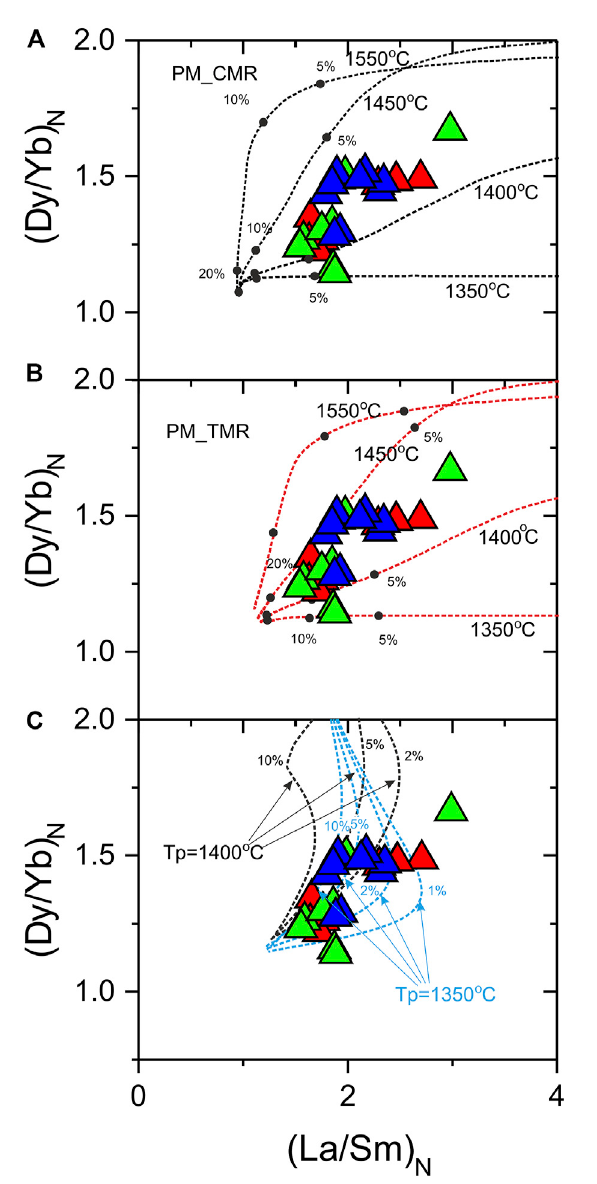
FIGURE 10 (La/Sm) N versus (Dy/Yb) N of the Ghatagaon, Keonjhar and Pipilia dyke swarms. (A) Forward models produced by melting primitive mantle in a columnar melting regime (PM_CMR) (McDonough and Sun, 1995)at mantle potential temperature from 1350 ° C to 1550 ° C. (B) Forward melting models produced by melting primitive mantle in a triangular melting regime (PM_CMR) (McDonough and Sun, 1995) at the same mantle potential temperatures in (A) . Black circles in the melting trajectories represent the degree of melting. (C) Forward model melts produced by melting hybrid lithologies of peridotite and pyroxenite (McDonough and Sun, 1995; Pertermann and Hirschmann, 2003). The mantle potential temperature is constrained between 1350 ° C and 1400 ° C and the proportions of pyroxenites in the source are indicated in percentage.